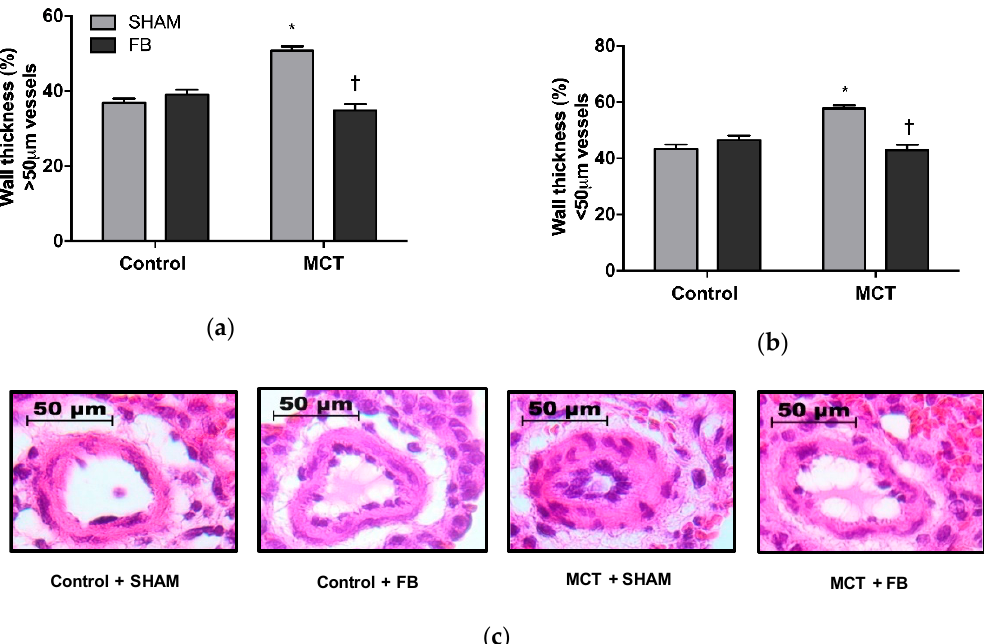
Figure 3. Xanthohumol-fortified beer (FB) intake improved PAH animals pulmonary vascular remodeling. Microscopic analysis of the large ( a ) and small ( b ) intrapulmonary arteries. Representative images of arteries from the different experimental groups ( c ). Data are mean ± SEM from samples of 8 animals per group. * p < 0.05 vs. respective control group, † p < 0.05 vs. MCT + SHAM. MCT: monocrotaline.